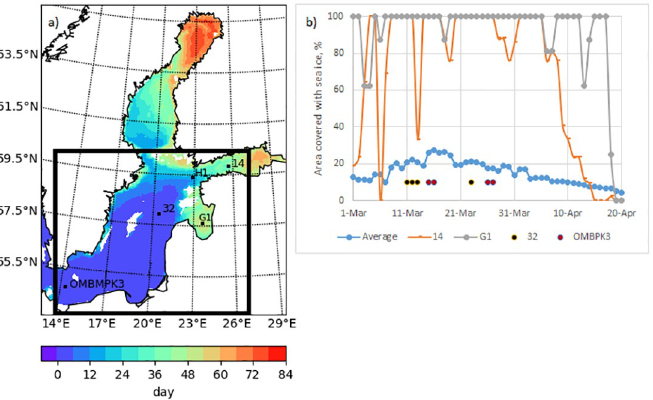
Fig 1. (a) Map of the Baltic Sea indicating stations (located in different physical-biogeochemical conditions) where modelled water densities and phytoplankton concentrations were analysed. The colour scale indicates the number of ice days since 1 March 2013. The black border represents the sea area for which the average is obtained; (b) The concentration of sea ice at stations and the average coverage over the